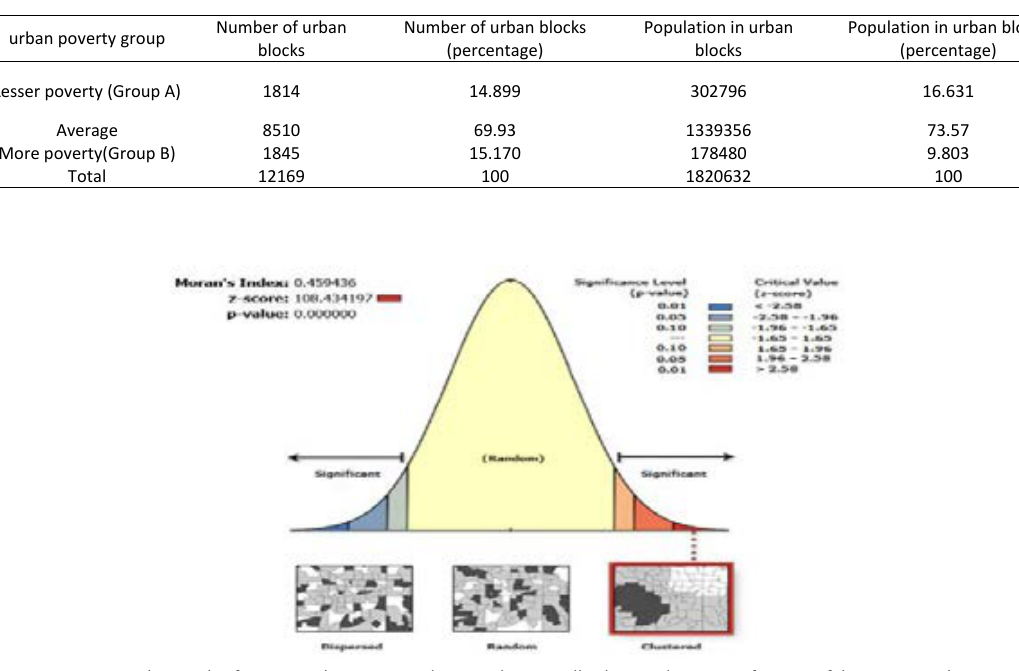
Table 5. Lesser poverty and more poverty group statistics Table 5: Lesser poverty and more poverty group statistics